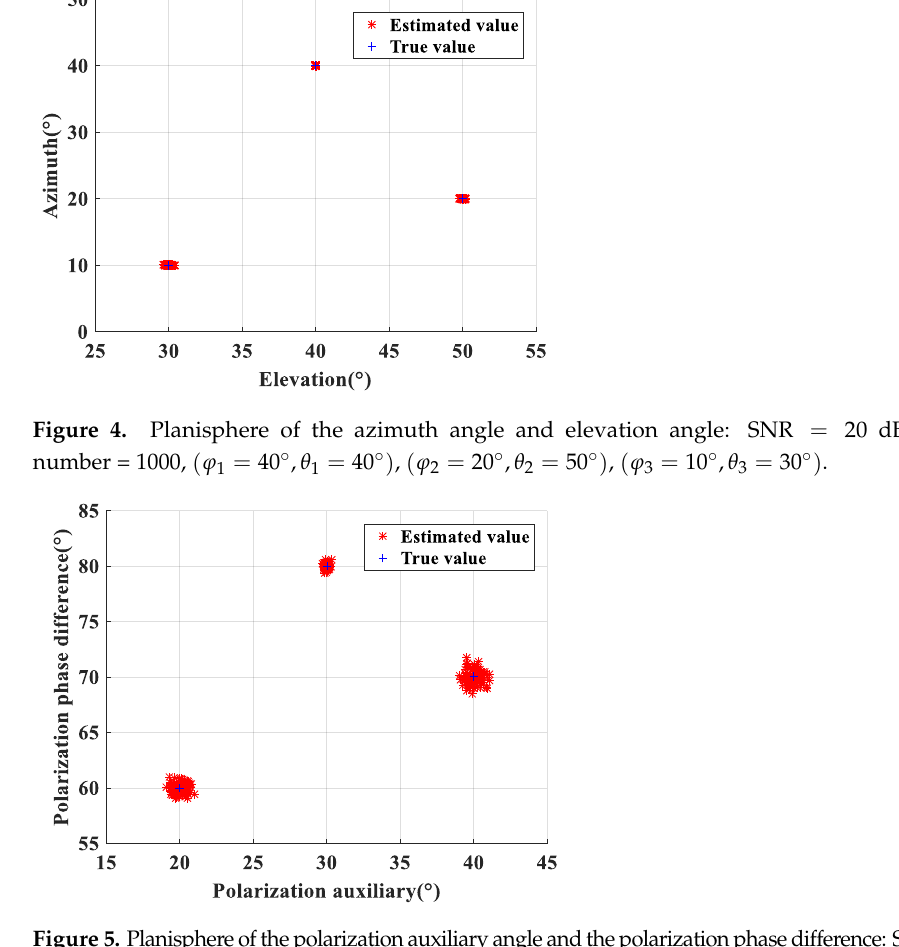
Figure 6. Estimation bias of the proposed algorithm: SNR